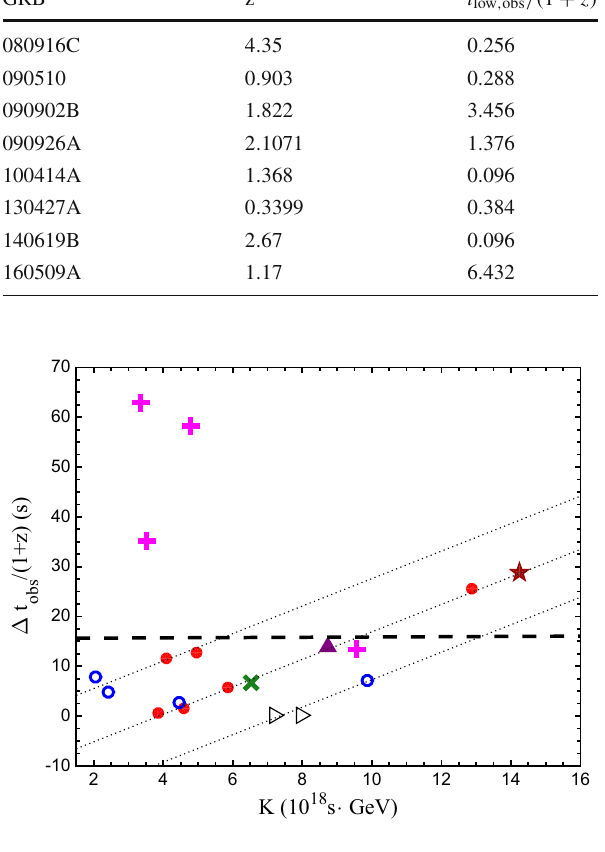
Fig. 4 The Δ t obs /( 1 + z ) - K plot for Band-Obs using Criterion 1. The dashed line marks the fit of all points, while the dotted lines were sug- gested in Refs.